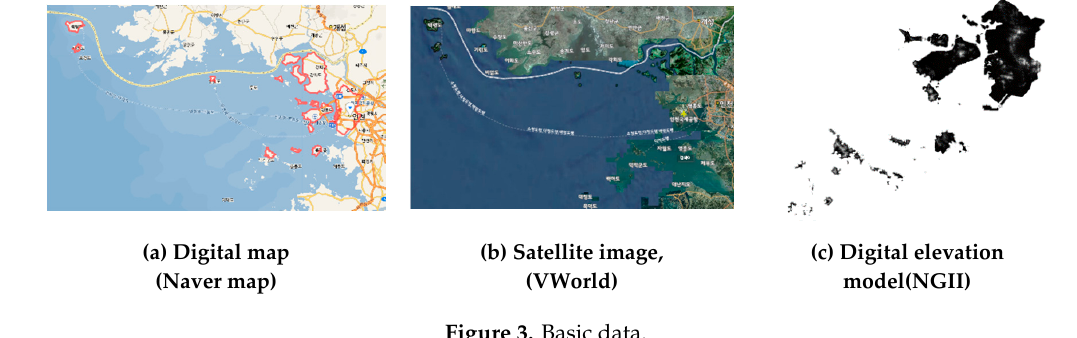
Figure 3. Basic Figure 3. Basic data.